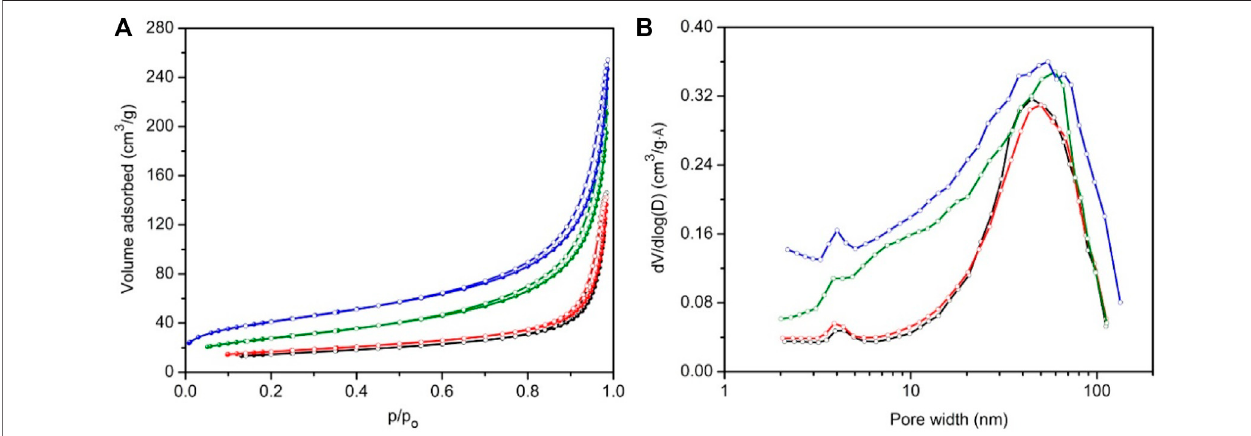
FIGURE 3| N 2 sorption isotherms (A) and BJH pore size distributions (B) of the samples prepared from geopolymer resin heated for 6 h at 60 ° C, namely, DGP-A- freeze-dried (blue), DGP-A-oven-dried (olive), DGP-W-freeze-dried (red) and DGP-A-oven-dried (black). For all samples, solid spheres and open circles represent adsorption and desorption branches,